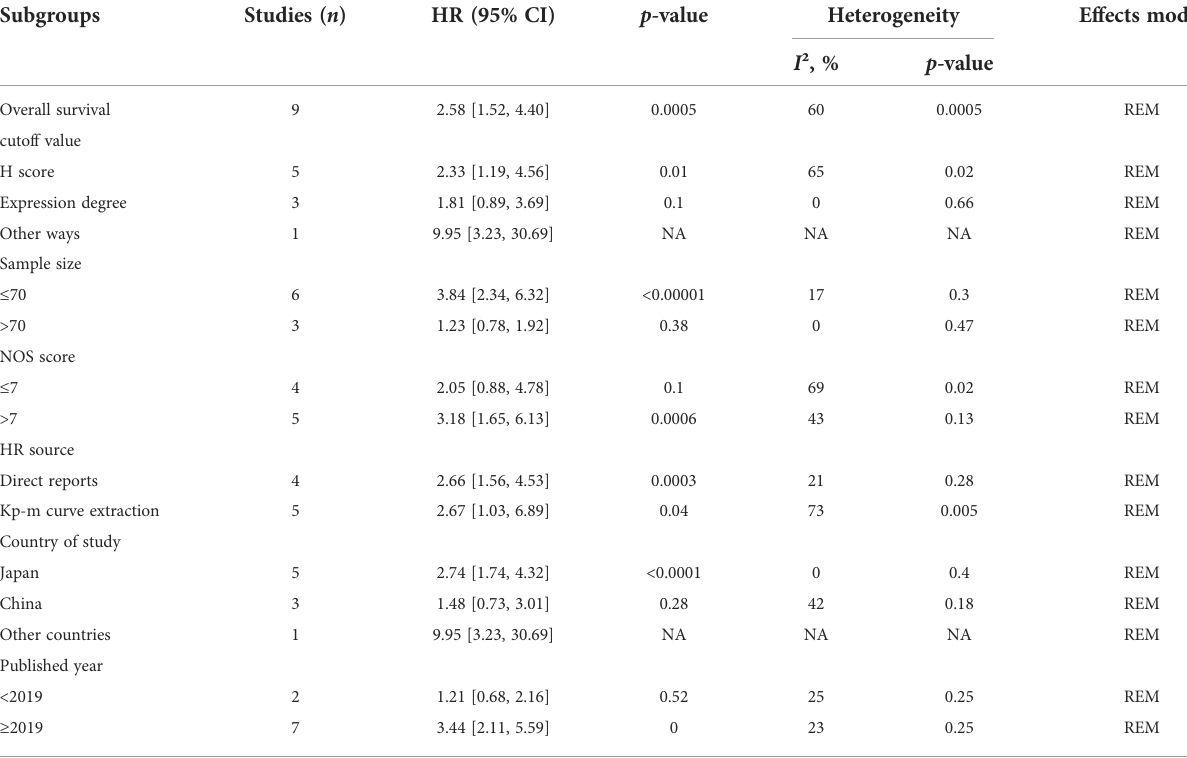
TABLE 5 A subgroup analysis was conducted to summarize studies of overall survival strati fi cation according to different